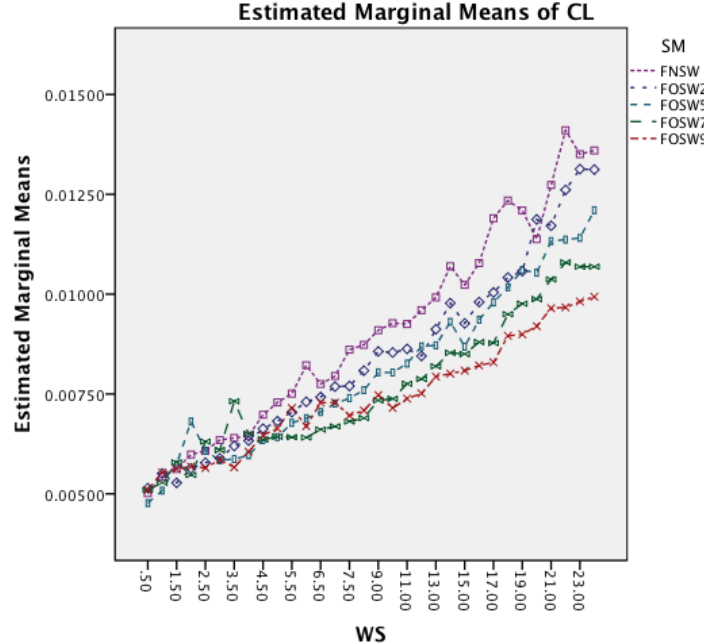
Figure 20. Two-way interaction effect for WS and